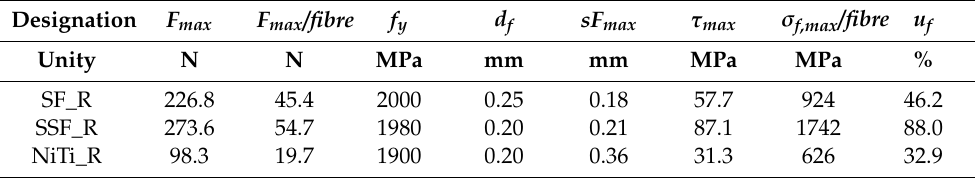
Table 3. Results of the fibre pullout tests for the di ff erent fibre types following laser surface treatment.